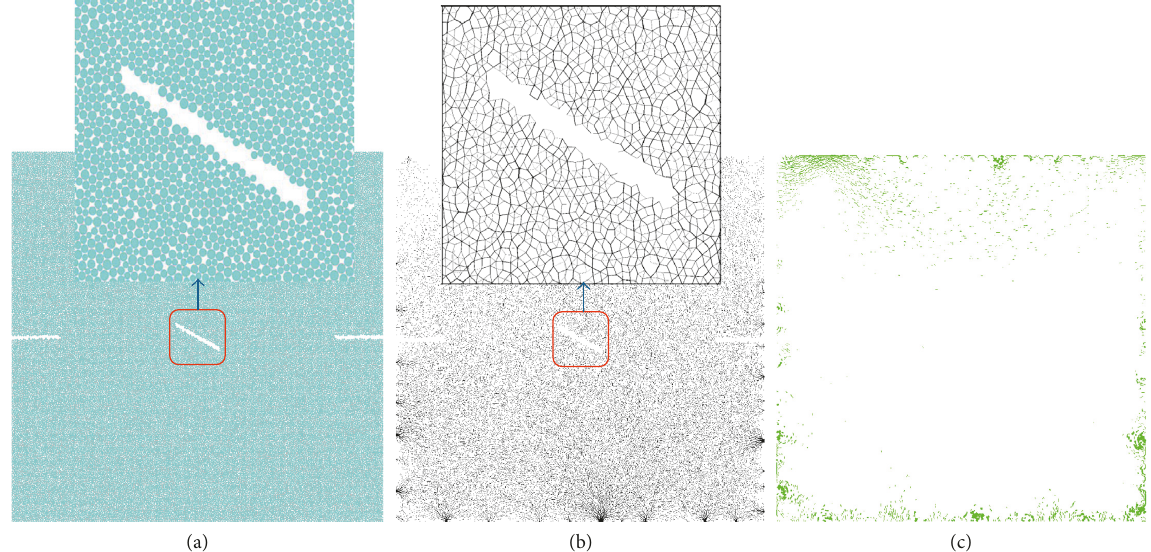
Figure 4: Jointed numerical model (A30): (a) intermittent joint model; (b) compressive contact force chain; (c) tensile contact force